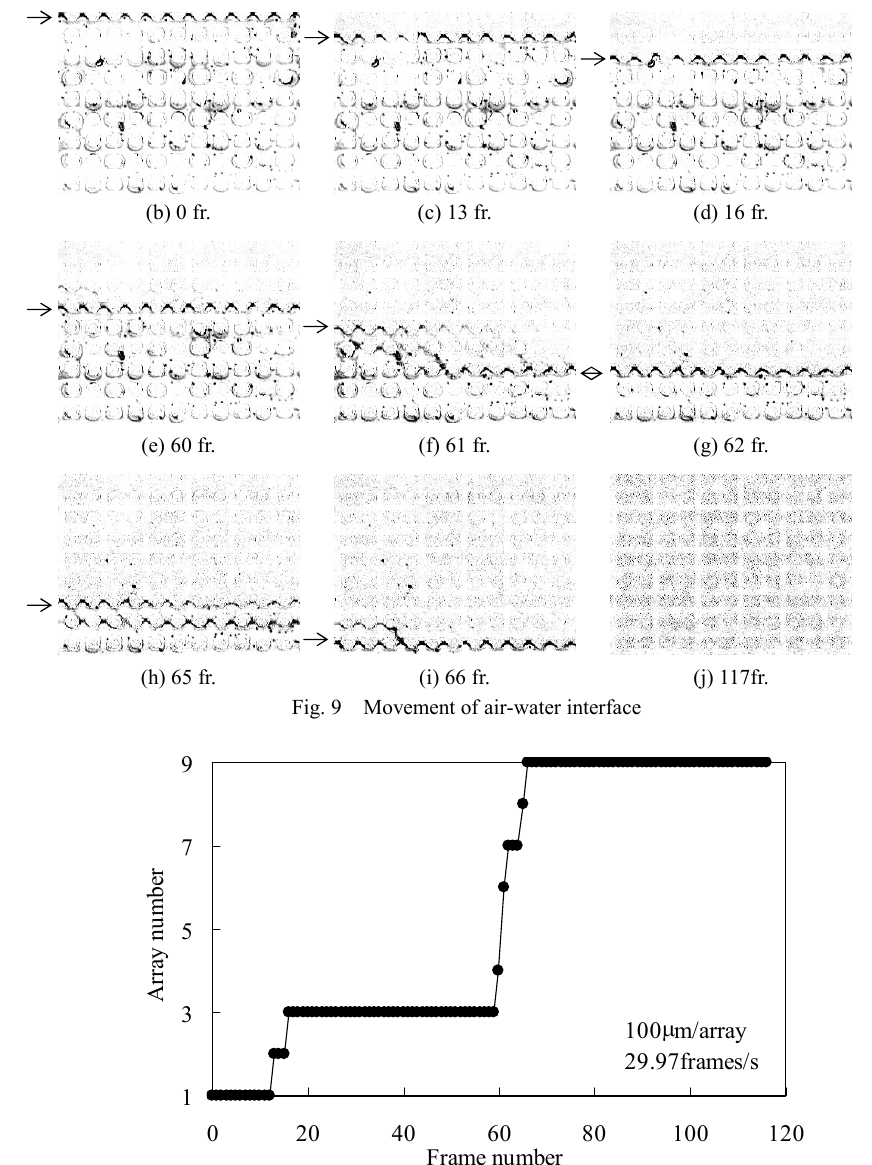
Fig. 10 Location of air-water interface in the observed